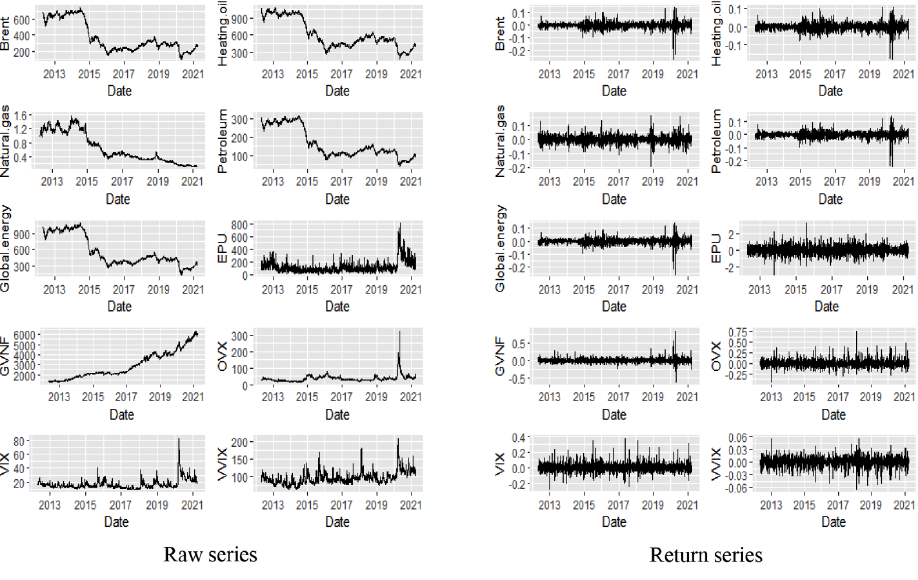
Figure 1. Time series